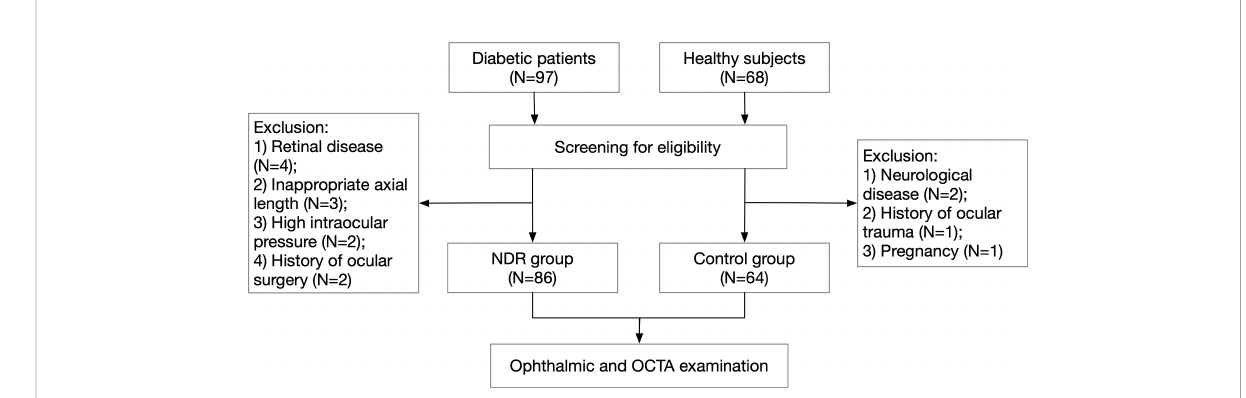
FIGURE 1 Flow diagram of patient selection. NDR, non-diabetic retinopathy; OCTA, optical coherence tomography